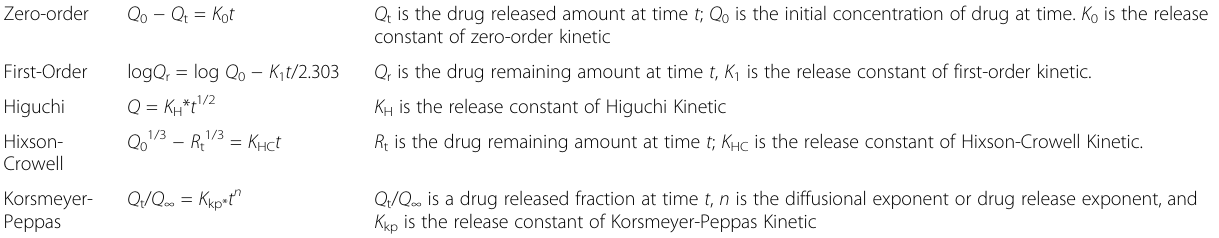
Table 1 description of some mathematical models used to determine drug release from drug delivery systems Zero-order